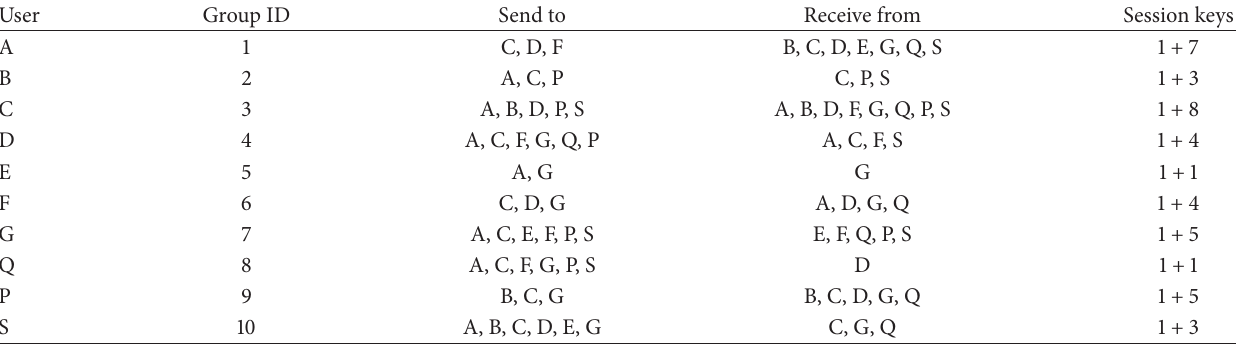
Table 3: Group IDs and session keys for each node.